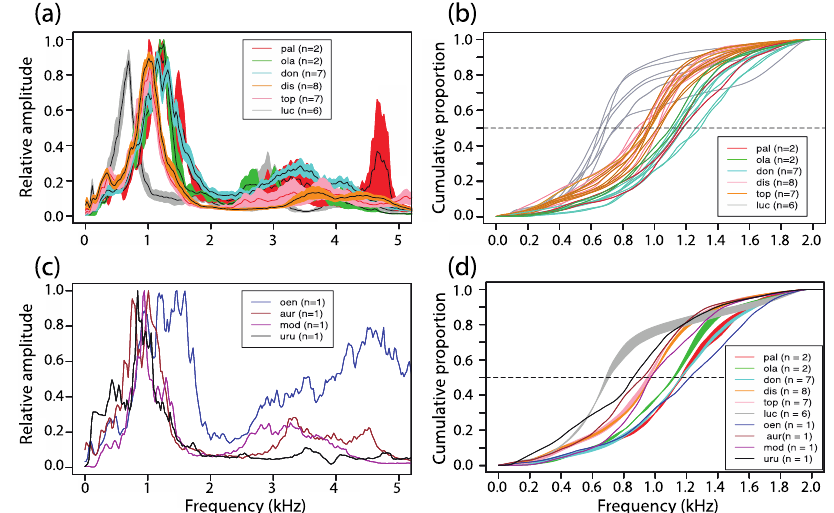
Figure 10. ( a ) Power spectra of vocal duets showing the distribution of sound energy as a function of frequency. The relative amplitude is shown as a proportion of the normalized signal amplitude. For each graph, the mean value (± SEMs) has been plotted and the largest peak represents the dominant frequency. The first three letters of each species’ name have been used as an acronym. The number of distinct groups that were analyzed is indicated by the n value. ( b ) The cumulative proportion of sound energy within the frequency band (80 – 2000 Hz) where the main peaks occurred is depicted for each duet. For statistical comparisons, frequency measurements were taken halfway up the cumulative curves (dashed line). ( c ) Power spectra of vocal duets in four species of titis for which only one group was available. Note the large rebound of sound energy at 4 to 5 kHz in the loud call of P. oenanthe the frequency band of 0.6 to 1.2 kHz.